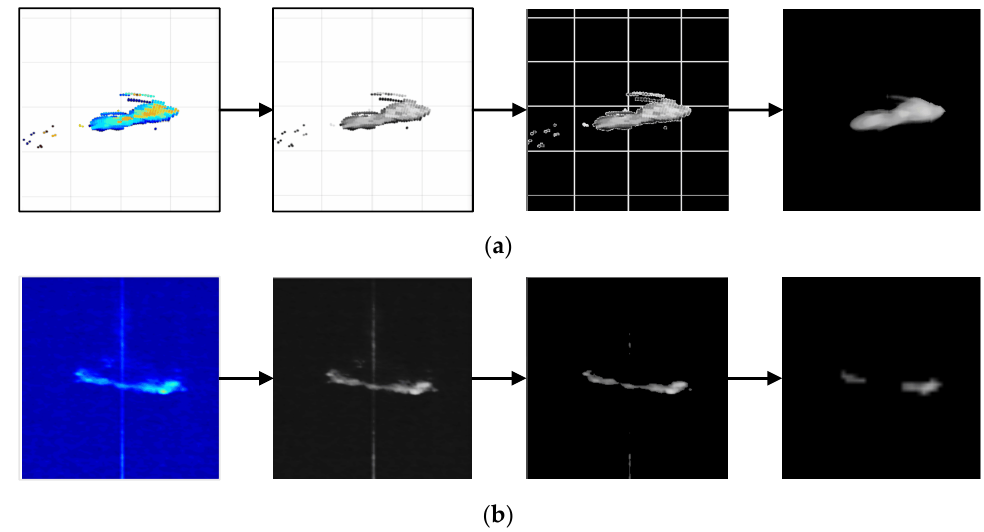
Figure 4. Image preprocessing: ( a ) preprocessing of the point cloud map; ( b ) preprocessing of the range–Doppler map.